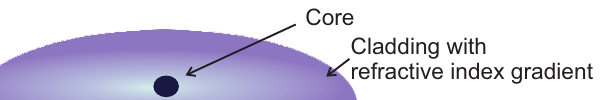
Figure 3. Cross section of a cured SWW with surrounding resin and gradually refractive index distribution. A darker color represents a higher refractive